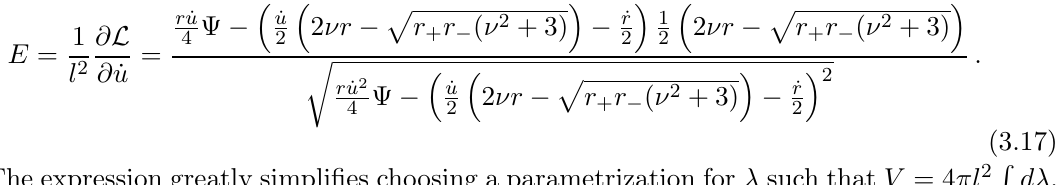
Figure 2 . Time dependence of dV parameter (cid:23)